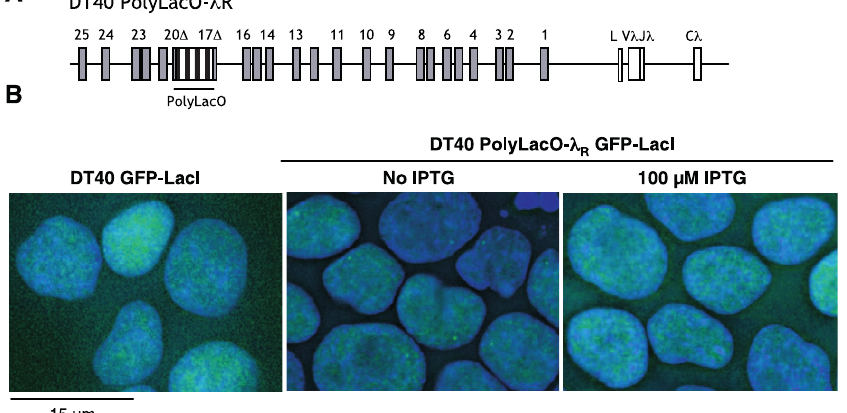
Figure 2. Reversible Tethering of GFP-LacI to the w V k Array in DT40 PolyLacO- k R (A) Schematic diagram of the rearranged chicken Ig k locus in DT40, with PolyLacO inserted between w V k 17 and w V k 20. Notations as in Figure 1. (B) Fluorescent images of DT40 GFP-LacI transfectants and DT40 PolyLacO-V k R GFP-LacI transfectants cultured in the absence of IPTG (center) or in the presence of 100 l M IPTG overnight (right).